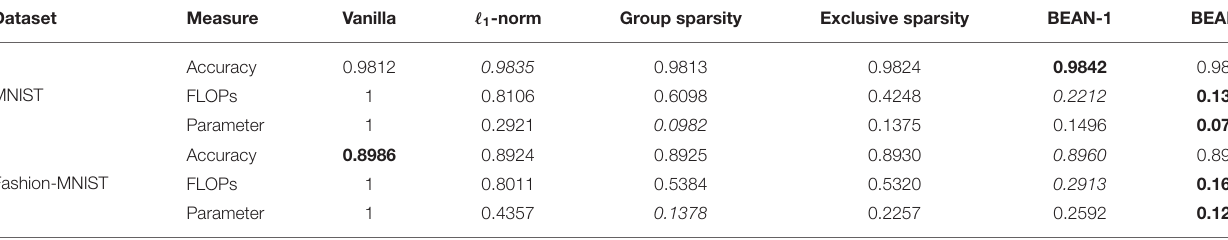
TABLE 1 | Efficient model learning experiments on MNIST and Fashion-MNIST datasets. Dataset